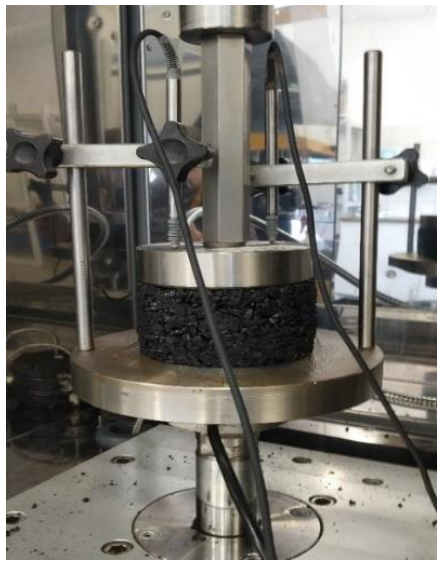
Figure 2. Test stand for the determination of uniaxial cyclic compression.